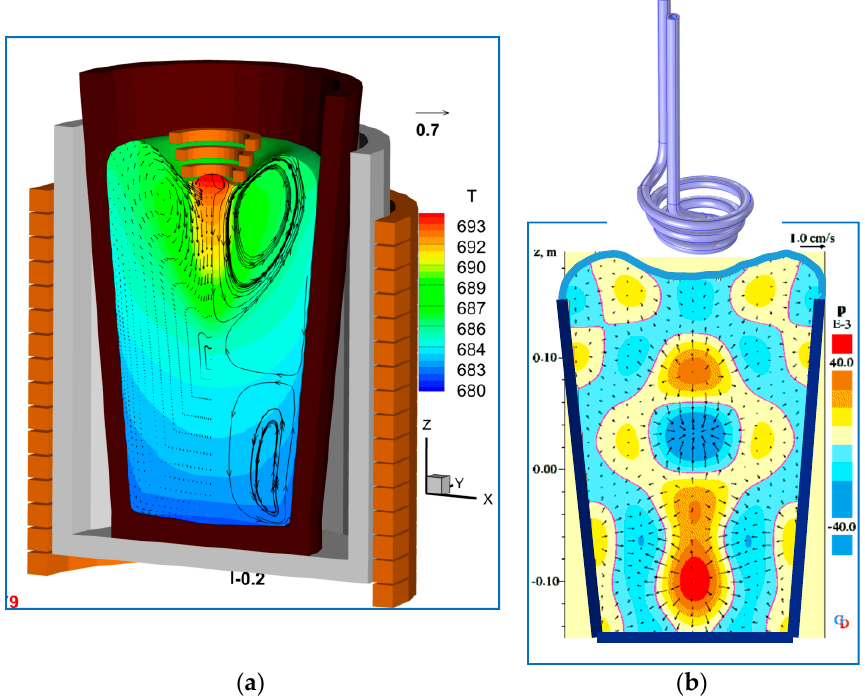
Figure 1. Simulations demonstrate the sonotrode concept [7]: ( a ) velocity and temperature <680–693 °C>, ( b ) instantaneous sound field < ± 40 kPa > with coil operating at 1000 A, 10